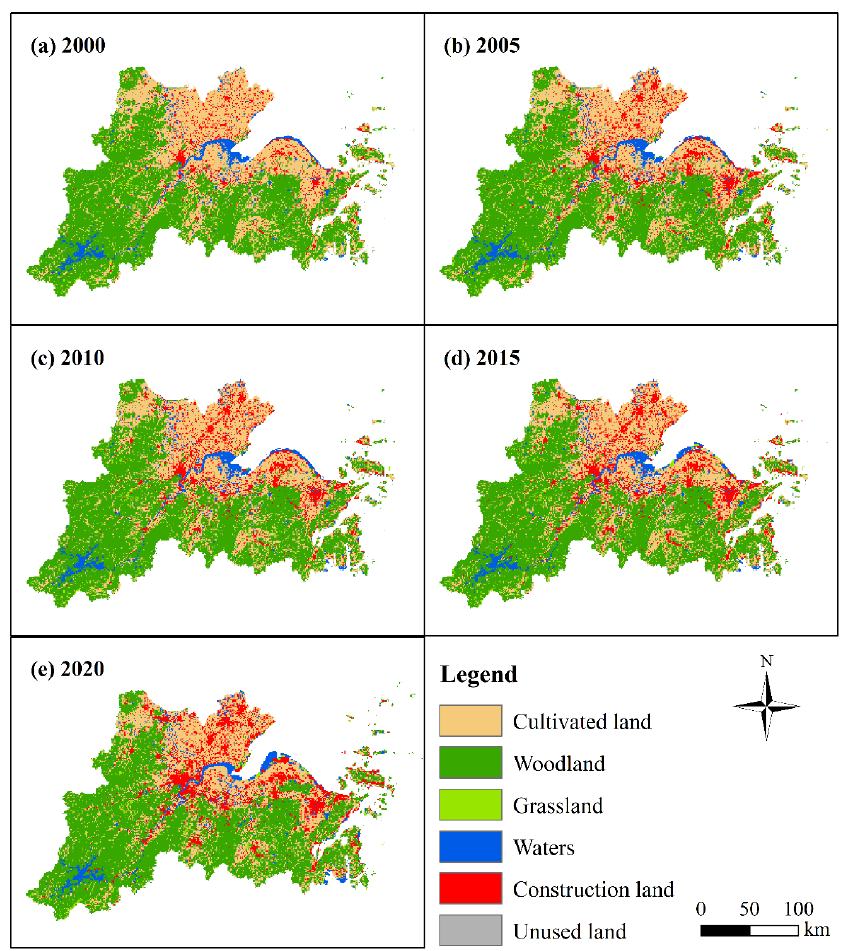
Figure 4. Characteristics of land-use change in HBUA from 2000 to 2020. At a city-level scale, the main land-use type in Hangzhou was woodland, and